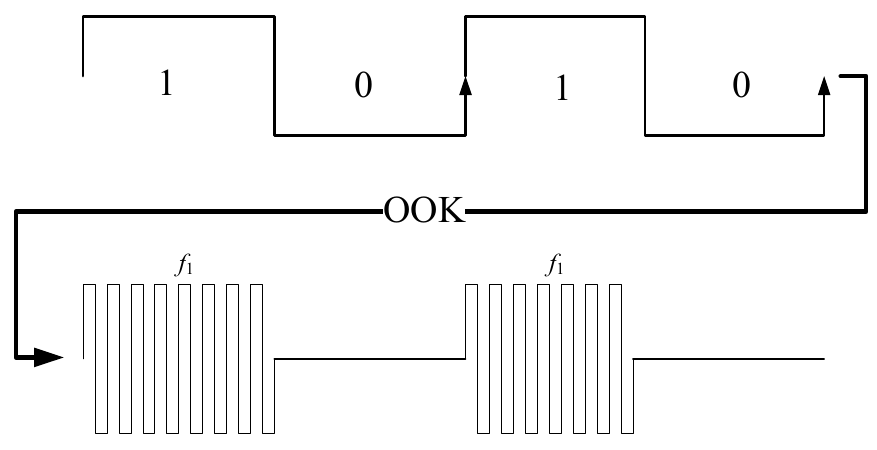
Figure 5. OOK modulation process.